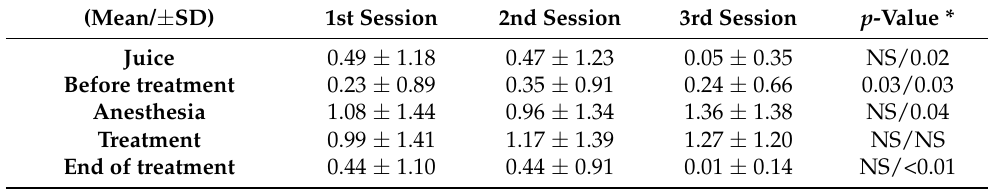
Table 3. Venham scores (intra-patient; 1st session n = 183; 2nd session n = 103; 3rd session n =